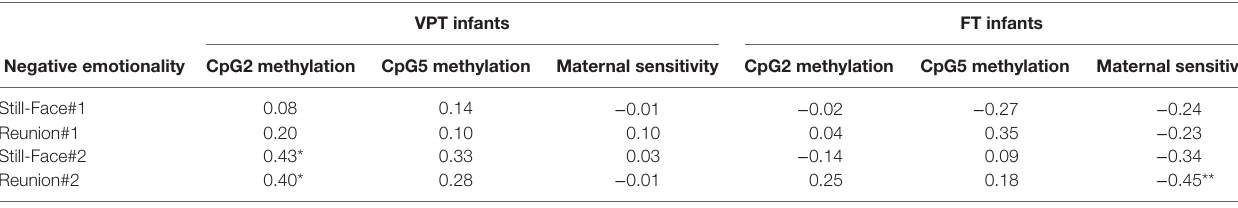
TaBle 2 | Preliminary correlations of SLC6A4 CpG-specific methylation and maternal sensitivity with infants’ negative emotionality. VPT infants FT